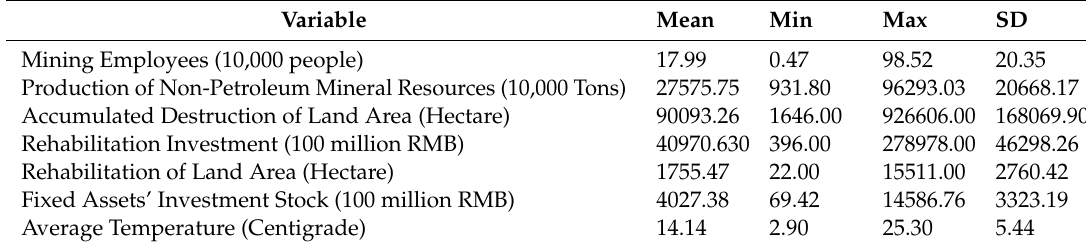
Table 2. Input and output